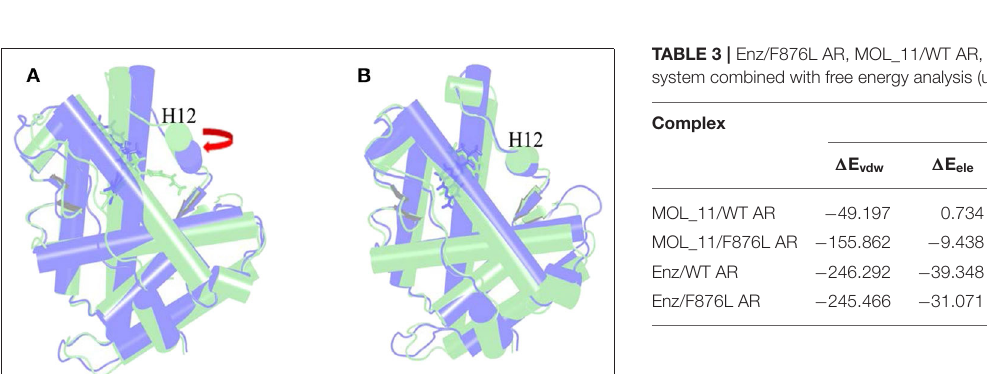
FIGURE 5 | RMSF value analysis chart. Red indicates the Enz/WT AR system; blue indicates the Enz/F876L AR system; black indicates MOL_11/WT AR system; purple indicates the MOL_11/F876L AR system.